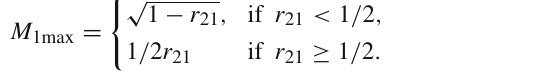
− M 12 2 (gray region) plane for EM4 and